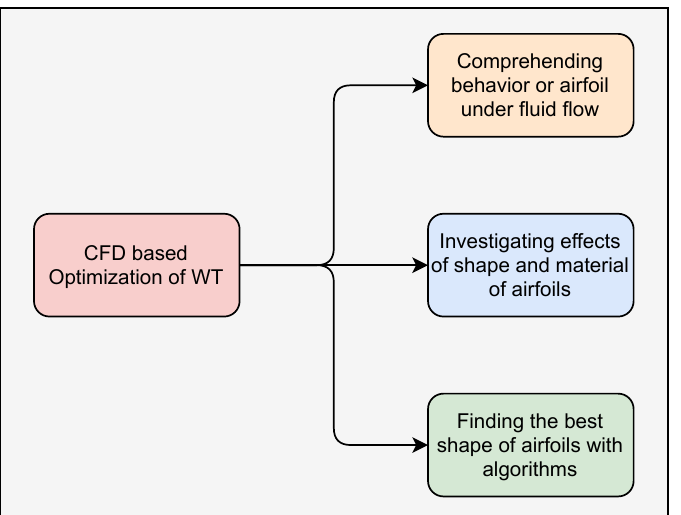
Figure 1. An illustration for computer fluid dynamics (CFD)-based optimization of wind turbines (WTs)